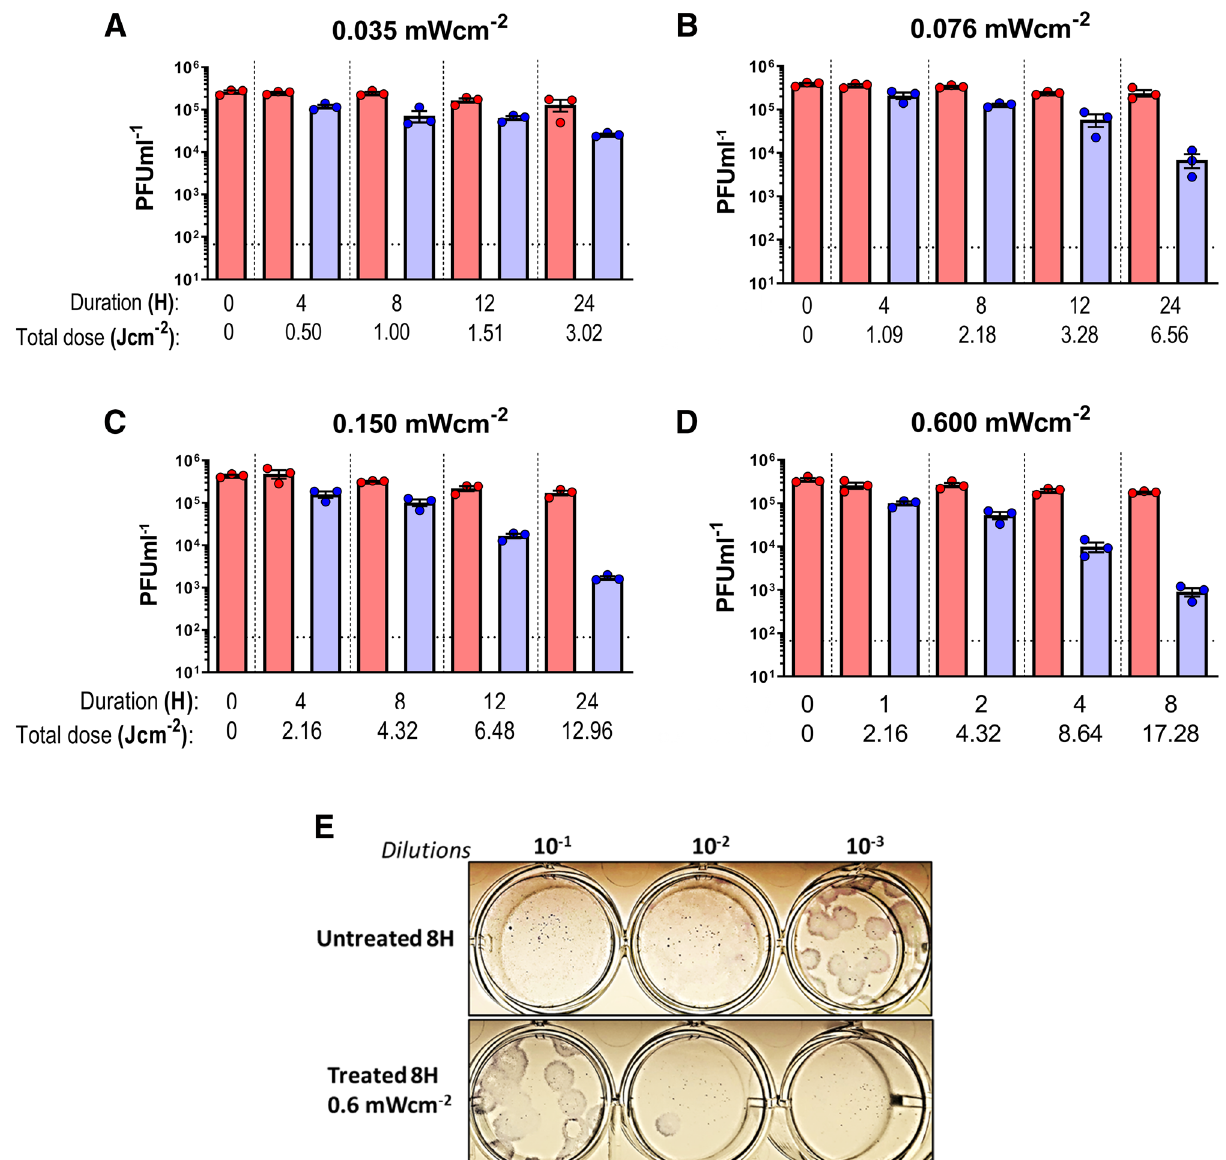
Figure 2. Dose and time dependent inactivation of SARS-CoV-2 virus in PBS by 405 nm irradiation. ( A ) A dose of 0.035 mW cm −2 or ( B ) a dose of 0.076 mW cm −2 or ( C ) a dose of 0.150 mW cm −2 or ( D ) a dose of 0.6 mW cm −2 was applied to irradiate samples at 405 nm over a course of 24 while sampling at 4, 8, 12 and 24 h (for A , B and C ) or over a course of 8 h while sampling at 1, 2, 4 and 8 h ( D ) was done in independent triplicates. Blue bars indicate treated samples and red bars correspond to the untreated equivalent that was left at the biosafety cabinet under the same conditions while not subjecting to disinfecting irradiation. Data shown as PFUml −1 in triplicate assessed by plaque assay. ( E ) Plaque phenotype comparison from one independent experiment at an irradiation dose of 0.6 mW cm −2 . Fixed and blocked plaques were immunostained using anti-SARS-CoV-2/NP antibody before developing using TrueBlue reagent. Data show in here are from three independent replicates (Mean + The stability of IAV virus at room temperature for a period of 8 h was found to be the negligible in untreated IAV spiked PBS samples (Fig. 3A). Encephalomyocarditis virus (EMCV) as a model non‑enveloped virus indicates reduced sus‑ ceptibility to 405 nm inactivation in the absence of photosensitizers. In order to better under- stand the effect of the lipid-envelope in viral inactivation by 405 nm irradiation, we used a non-lipid enveloped RNA virus derived from the Picornaviridae family. EMCV virus was irradiated at a high dose of 0.6 mW cm −2 similar to SARS-CoV-2 and IAV.